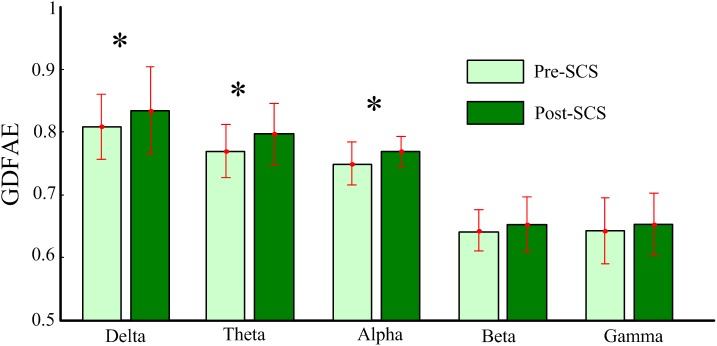
Descriptive statistics for the averaged GDFAE for all patients. This includes the bar (mean) and the error bar (standard deviation) of the averaged GDFAE at five frequency bands, at pre- and post-SCS states. The asterisk denotes a p-value less than 0.05 in multiple comparison test, with Bonferroni correction.